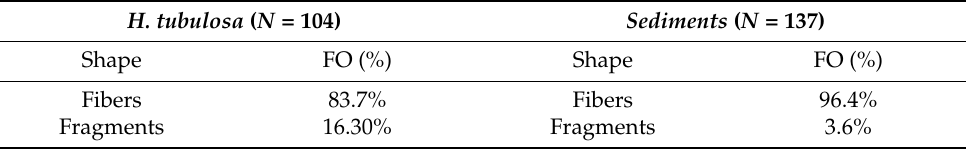
Table 1. Total number of MPs in the studied areas in H. tubulosa and sediments and frequency of occurrence (FO) of different shape and